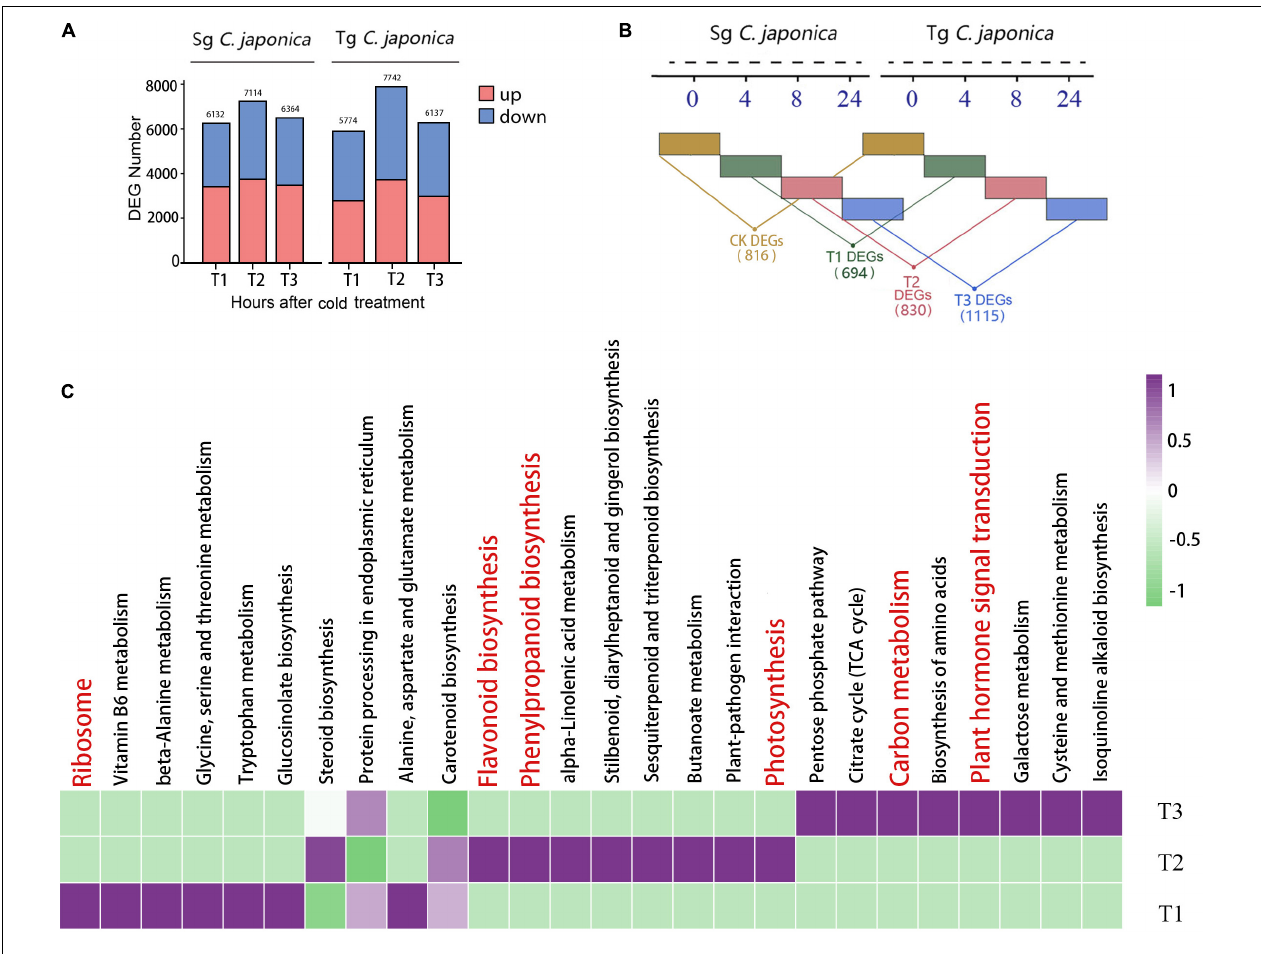
FIGURE 3 | Divergence in the response to cold between Tg and Sg C. japonica . (A) The number of DEGs and DEPs after the T1, T2, and T3 cold treatments. (B) Representation of DEGs between two camellias under the same cold treatment. Numbers in parentheses show the number of DEGs within a category. (C) Top 26 enriched KEGG pathways of these three